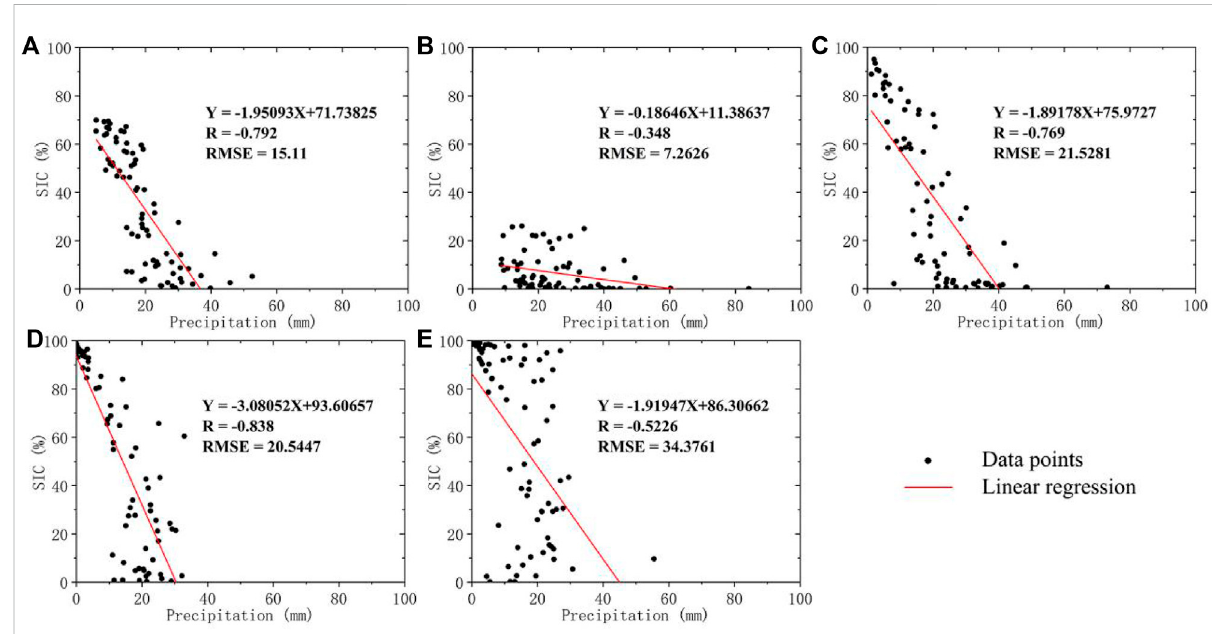
FIGURE 7 LinearregressionofSICagainstmonthlyprecipitationin (A) theNEP, (B) BarentsSea, (C) KaraSea, (D) LaptevSea,and (E) EastSiberianSeaforthe period May – December for 2011 – 2020. All of the correlation coef fi cients passed the signi fi cance test ( p < 0.01).